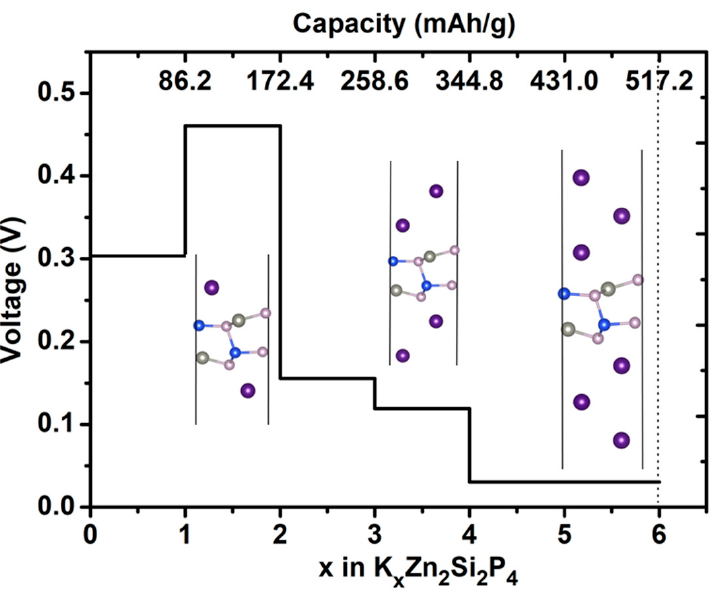
Figure 7. Predicted voltage as a function of capacity and K content ( x ) in K x Zn 2 Si 2 P 4 .